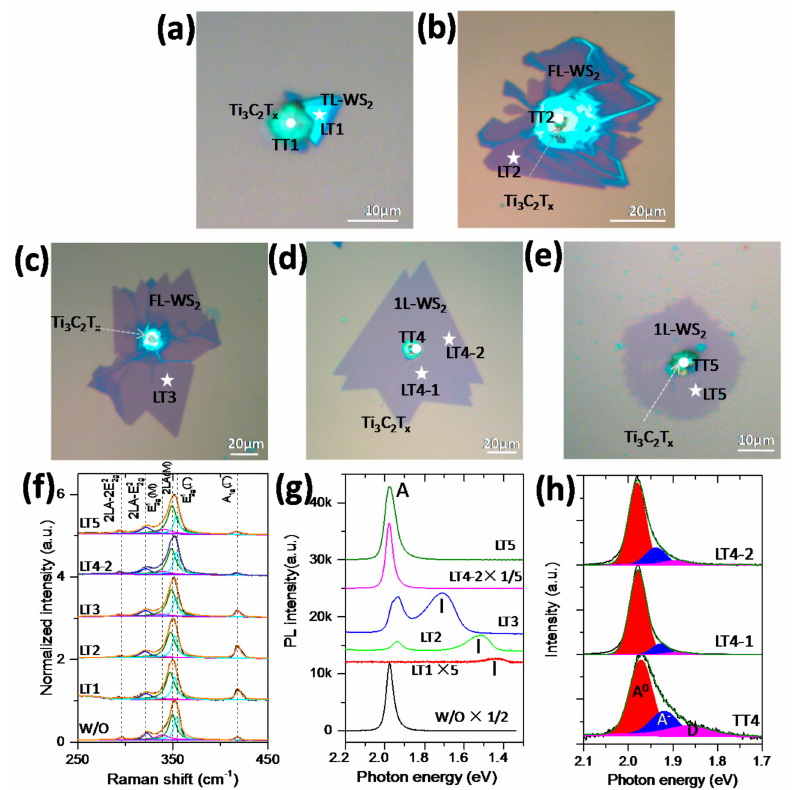
Figure 3. ( a – e ): optical images of five WS 2 flakes (T1–T5) with different thickness deposited with Ti 3 C 2 T x mxene; ( f ) Raman and ( g ) PL spectra of collected on locations LT1–LT5 on WS 2 flake T1–T5; ( h ) Deconvolution of PL spectra collected from different locations TT4, LT4-1 and LT4-2 (marked in ( d )) of WS 2 flake T4. Note that the PL intensities of some flakes are divided by a factor for clear comparison. The Raman spectra are normalized for clear comparison. The Raman and PL spectra of 1 L-WS 2 deposited without mxene (W/O) in Figure 1b are also shown in ( f , g ), respectively, for